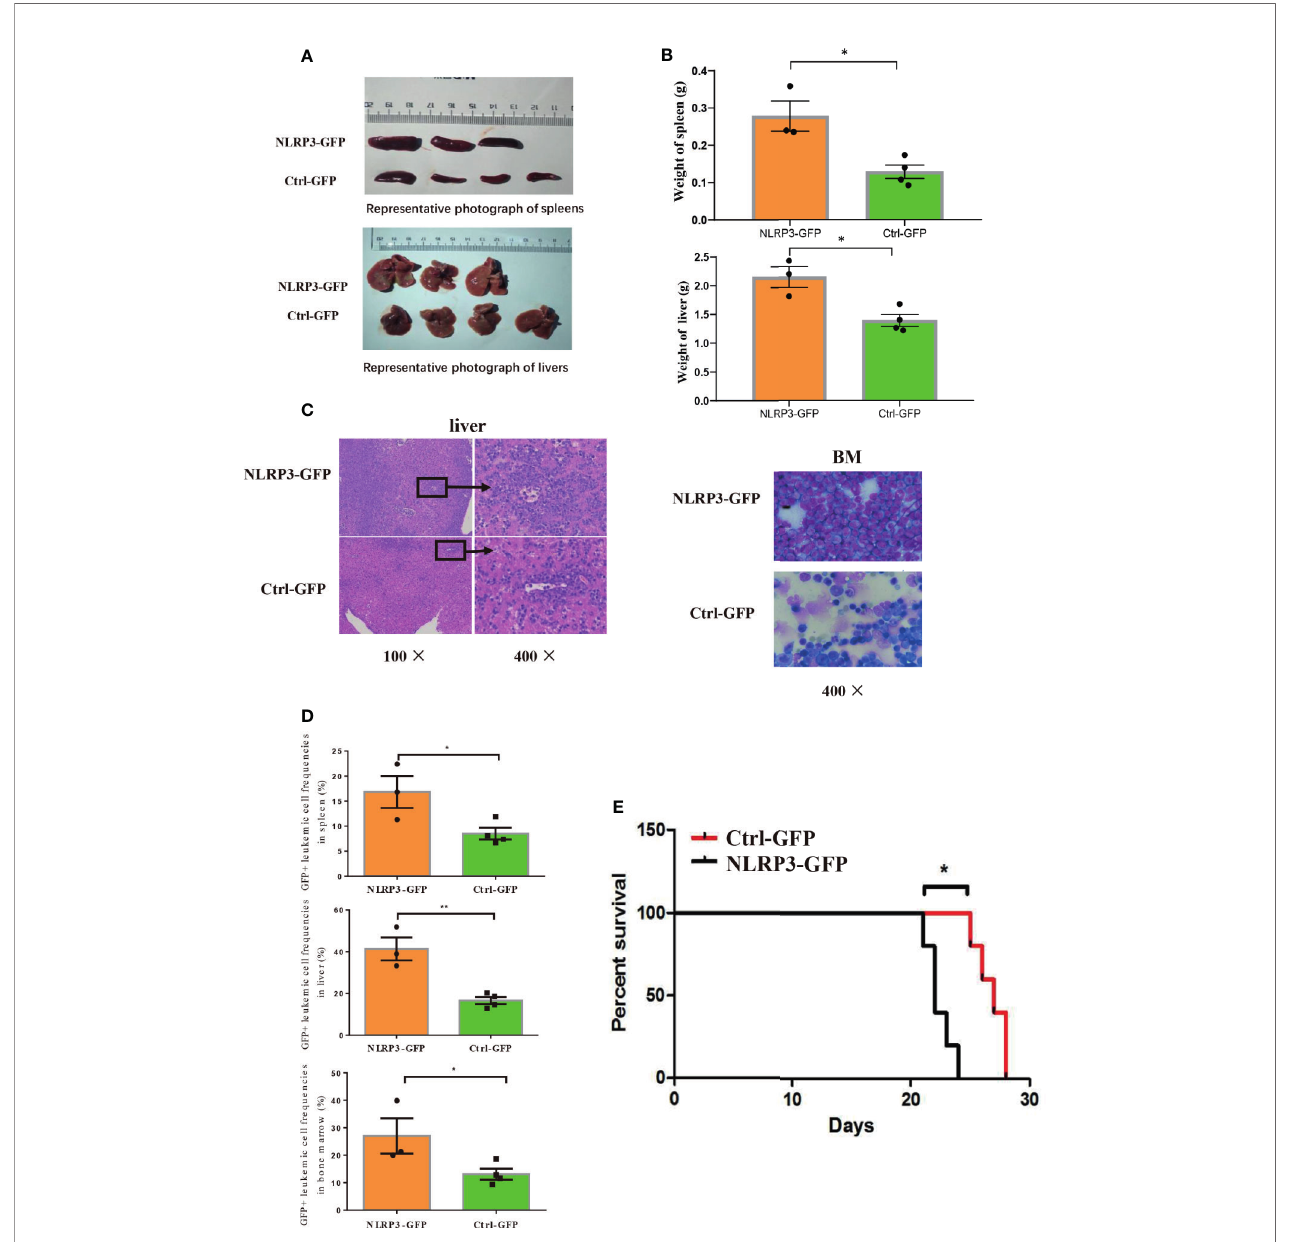
FIGURE 2 | Up-regulation of NLRP3 promotes AML progression and shortens survival in AML mice. (A) Representative photographs of spleen and liver from NLRP3-GFP mice (n=3), Ctrl-GFP mice (n=4) are compared, (B) with the analysis of the weight of spleens and livers of NLRP3-GFP (n=3) and Ctrl-GFP mice (n=4). (C) Hematoxylin and eosin – stained histopathology sections of a representative liver and bone marrow from Ctrl-GFP and NLRP3-GFP mice (100× or 400×). (D) The leukemia cells (GFP+ cells) in spleen, liver and bone marrow from NLRP3-GFP (n=3) and Ctrl-GFP (n=4) mice. (E) Kaplan-Meier survival curve of mice leukemia model (n=5 per group). *P < 0.05; **P <